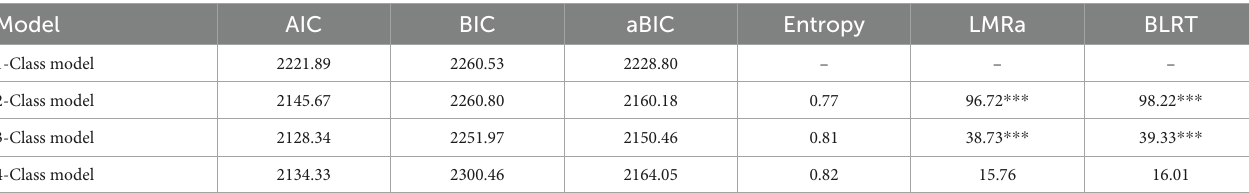
TABLE 2 Comparison of latent class